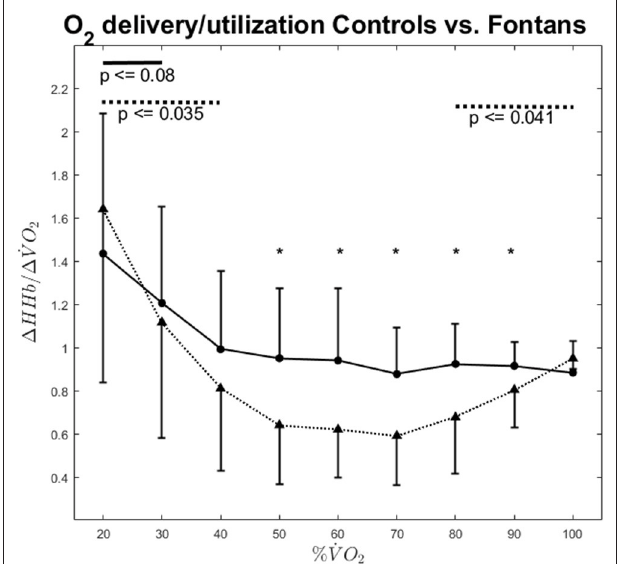
FIGURE 4 | Ventilation vs. exercise intensity for Fontans (solid line) and Controls (dashed line). The solid and dashed lines in the upper section indicate significant differences between intensities among Fontans and Controls, respectively. Significant differences ( p < 0.05) between Fontans and Controls within one exercise intensity are marked with